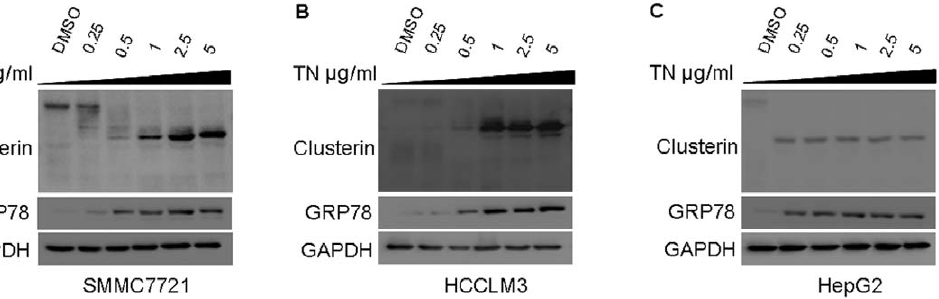
Figure 1. TN induces the expressions of CLU and GRP78 in HCC cell lines invitro . (A–C) SMMC7721, HCCLM3 and HepG2 cells were treated for 24 h with TN for the indicated doses. Protein extracts were analyzed for CLU, GRP78 and GAPDH. TN treatment induced both CLU and GRP78 expressions and the molecular weight of CLU was decreased after TN treatment.